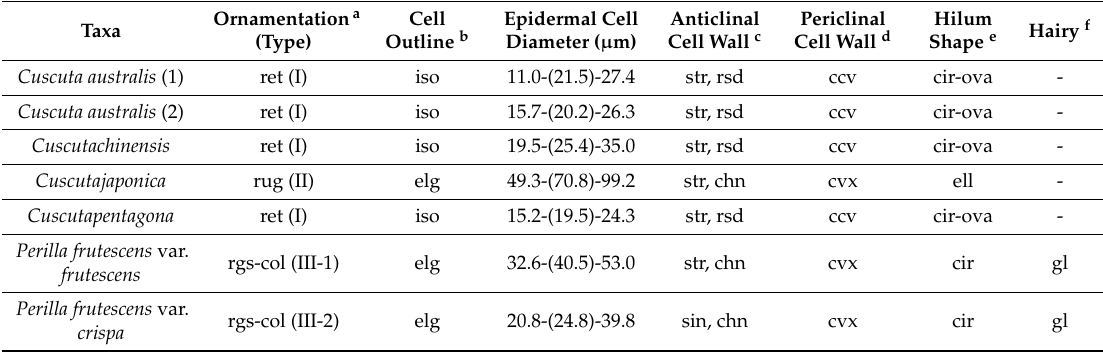
Figure 4. Scanning electron micrographs showing the seed ( A , D , G ), detailed testa ornamentation ( B , E , H ), and the hilum ( C , F , I ). ( A – C ) Cuscuta pentagona . ( D – F ) Perilla frutescens var. frutescens . ( G – I ) P. frutescens var. crispa . ( I ) Detailed glandular trichomes. Table 2. Seed micromorphological characteristics of original species of Cuscutae Semen, congeneric, and adulterant